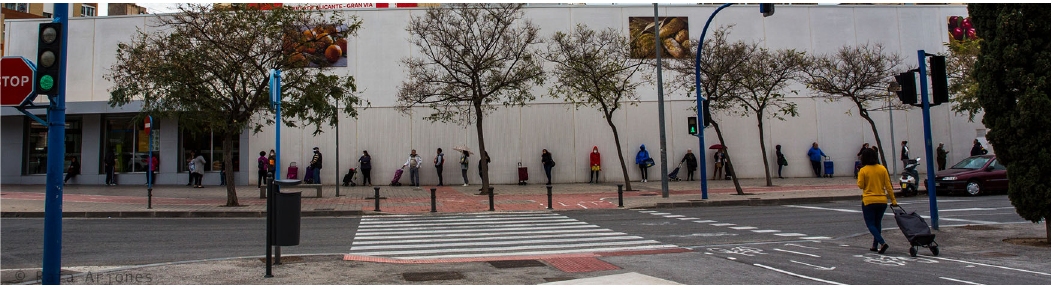
Figure 3. Long horizontal facade of a supermarket. People are seen waiting to be able to buy and keeping the presribed safe distance. In those moments, when it was possible to go out to the street, waiting becomes one of the main moments in which there is a certain social relationship. This figure has been reproduced with kind permission of the author.